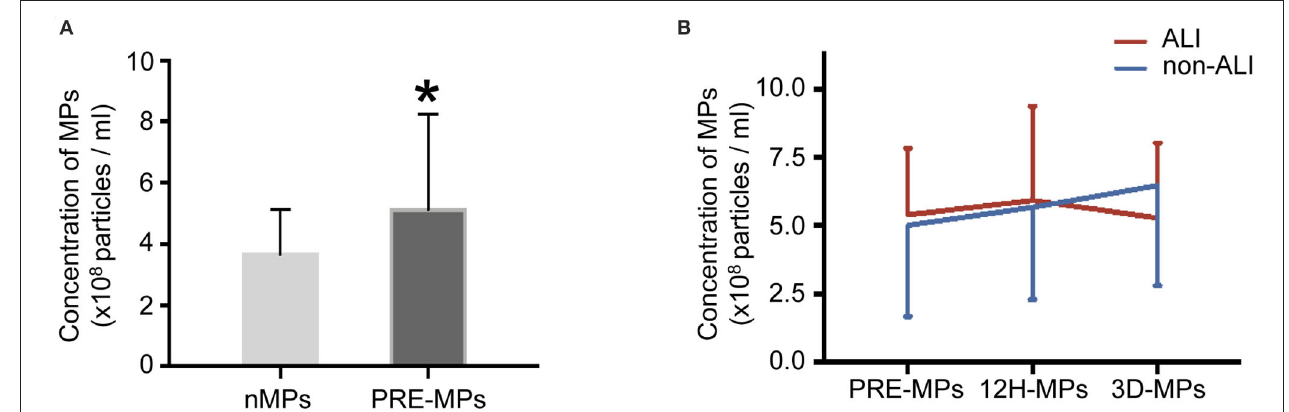
FIGURE 2 | Concentrations of circulating microparticles (MPs) in all patients and healthy subjects. (A) The concentrations of MPs in healthy subjects and patients. (B) The concentrations of MPs at different perioperative times between ALI and non-ALI groups. *, vs. nMPs, P < 0.05. nMPs, MPs from healthy subjects; PRE-MPs, MPs from pre-operation; 12H-MPs, MPs from 12h after operation; 3D-MPs, MPs from 3 d after the operation.